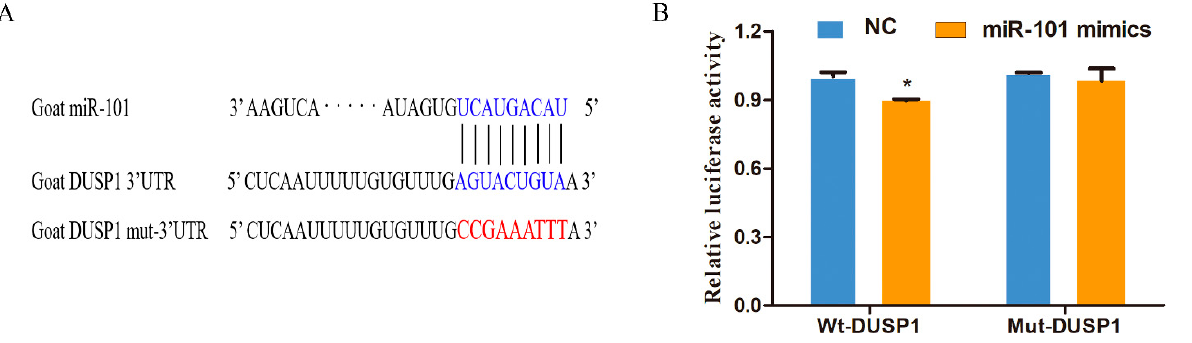
Figure 1. MiR-101 can directly target the 3 ′ UTR of the DUSP1 gene in hair follicle stem cells: ( A ) The predicted binding sites of miR-101 and DUSP1 ; the bases marked with blue represent the wild-type, and those in red represent the mutant-type; ( B ) Detection of dual-luciferase activity after co-transfection of NC or miR-101 with wild or mutant-type DUSP1. No asterisk, p > 0.05; *, p < 0.05.